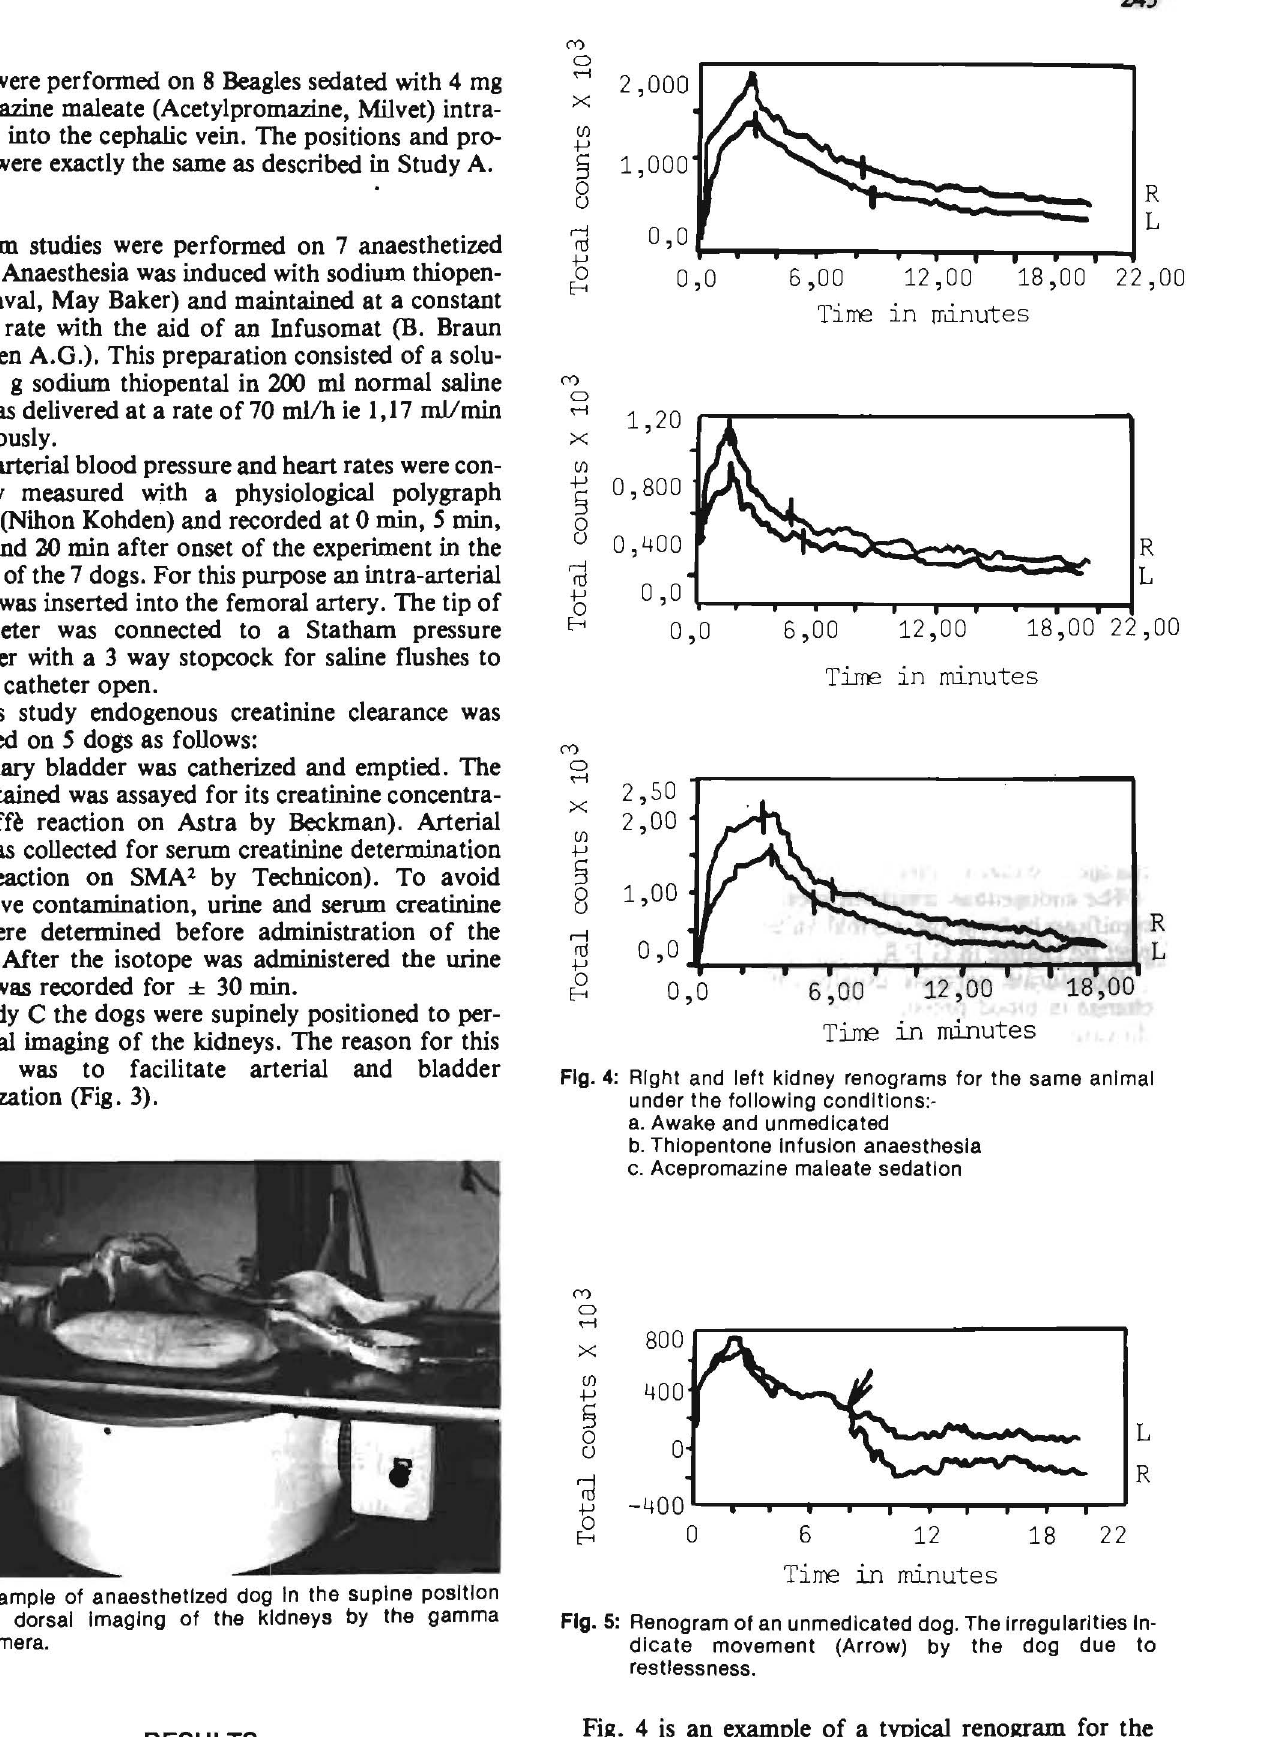
Fig. 5: Renogram of an unmedlcated dog. The irregularities In· dicate movement (Arrow) by the dog due to restlessness. Fig. 4 is an example of a typical renogram for the same animal under the 3 different studies. Fig. S is a renogram of a conscious dog showing the irregularities due to movement while Fig. 6 is that of an anaesthetized dog to show the effect of a bolus injection of thiopen